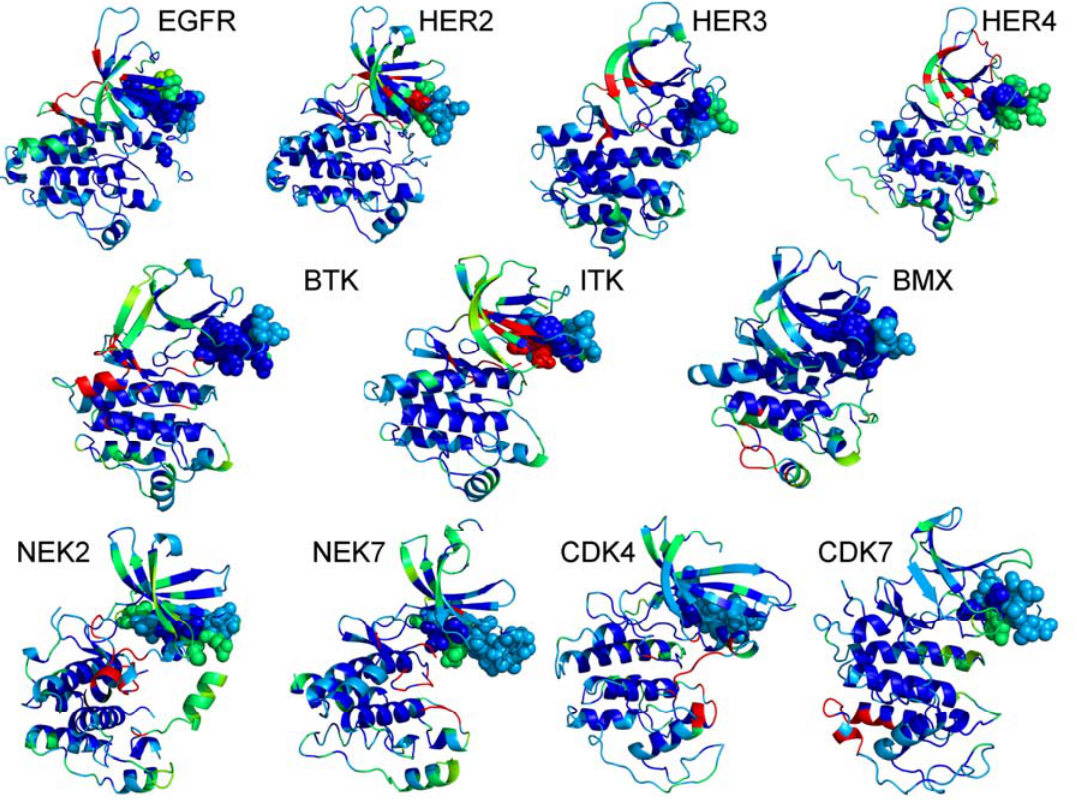
Figure 3. The Interaction Maps of the Protein Kinase Clients. Structural mapping of interaction preferences of various kinase clients onto the crystal structures. The protein- protein interaction predictor methods ProMate , InterProSurf and SPPIDER (C) was used to build a consensus scoring of probable interfacial residues. The distribution of interfacial regions in the crystal structures is represented by a color scheme, where blue corresponds to the regions with the lowest probability and red corresponds to the regions with the highest probability to interface with binding